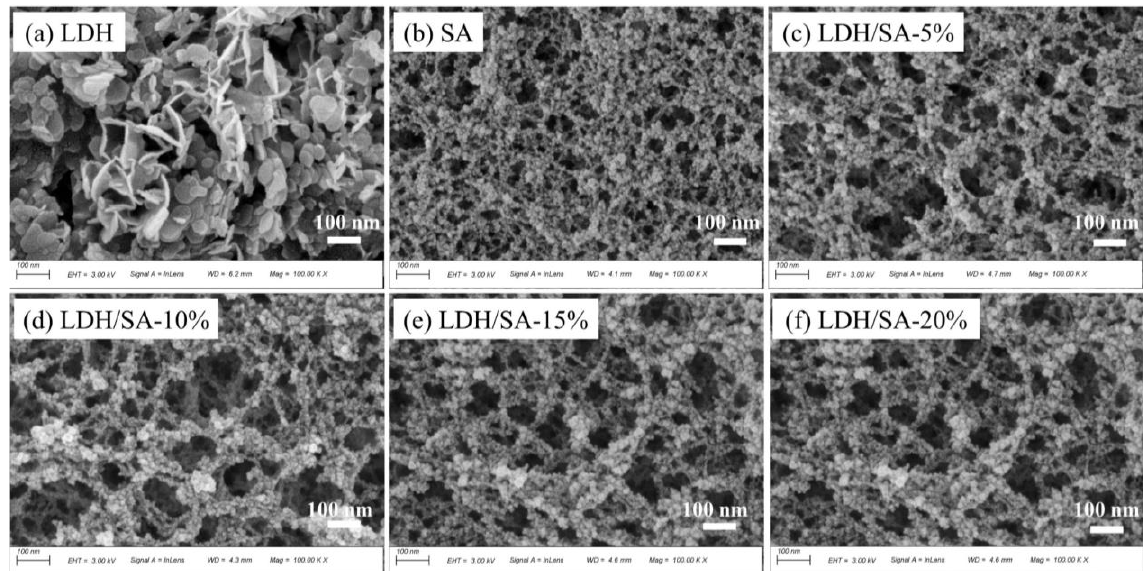
Figure 3. SEM images of MgAl-LDH ( a ), SA ( b ), and LDH/SA-5%~20% ( c – f ).